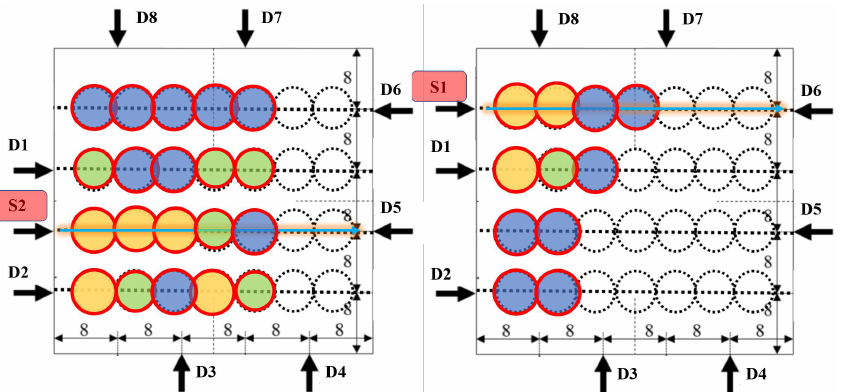
Figure 10. Distributions of detection probabilities for an incident beam from S2 ( left panel ) and S1 ( right panel ): yellow domains highlight most probable positions for detection, while green domains correspond to moderate probabilities and blue domains correspond to low probabilities.